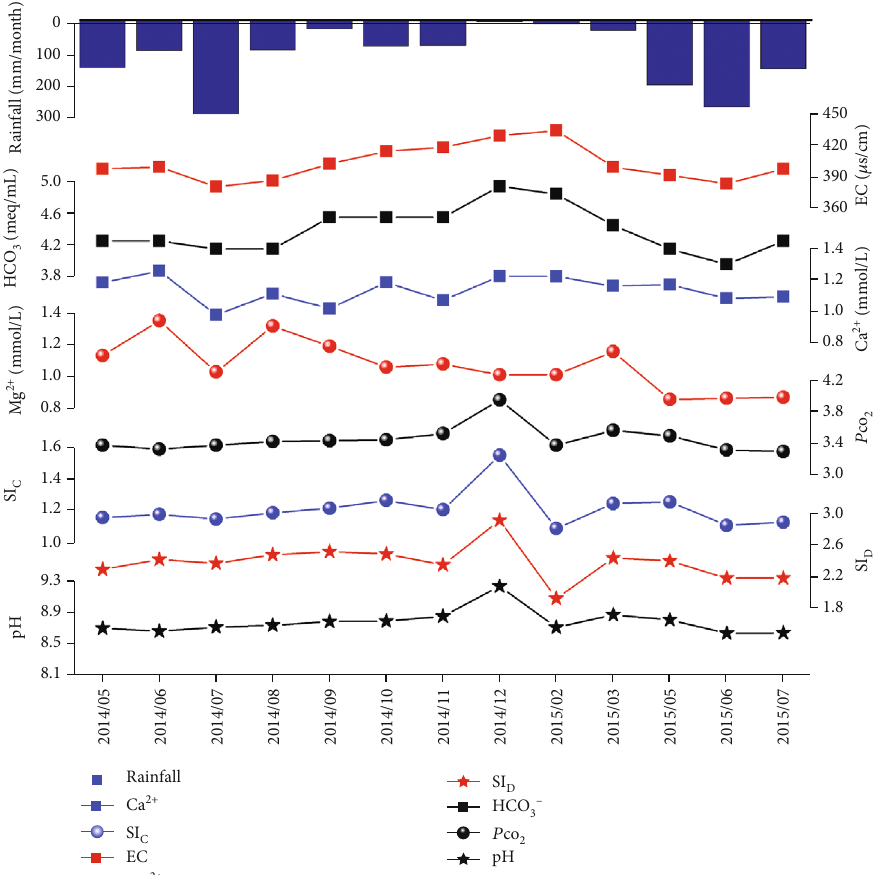
Figure 5: Monthly variation of the hydrochemistry of No. 4 water in outlet of Huangzhouhe